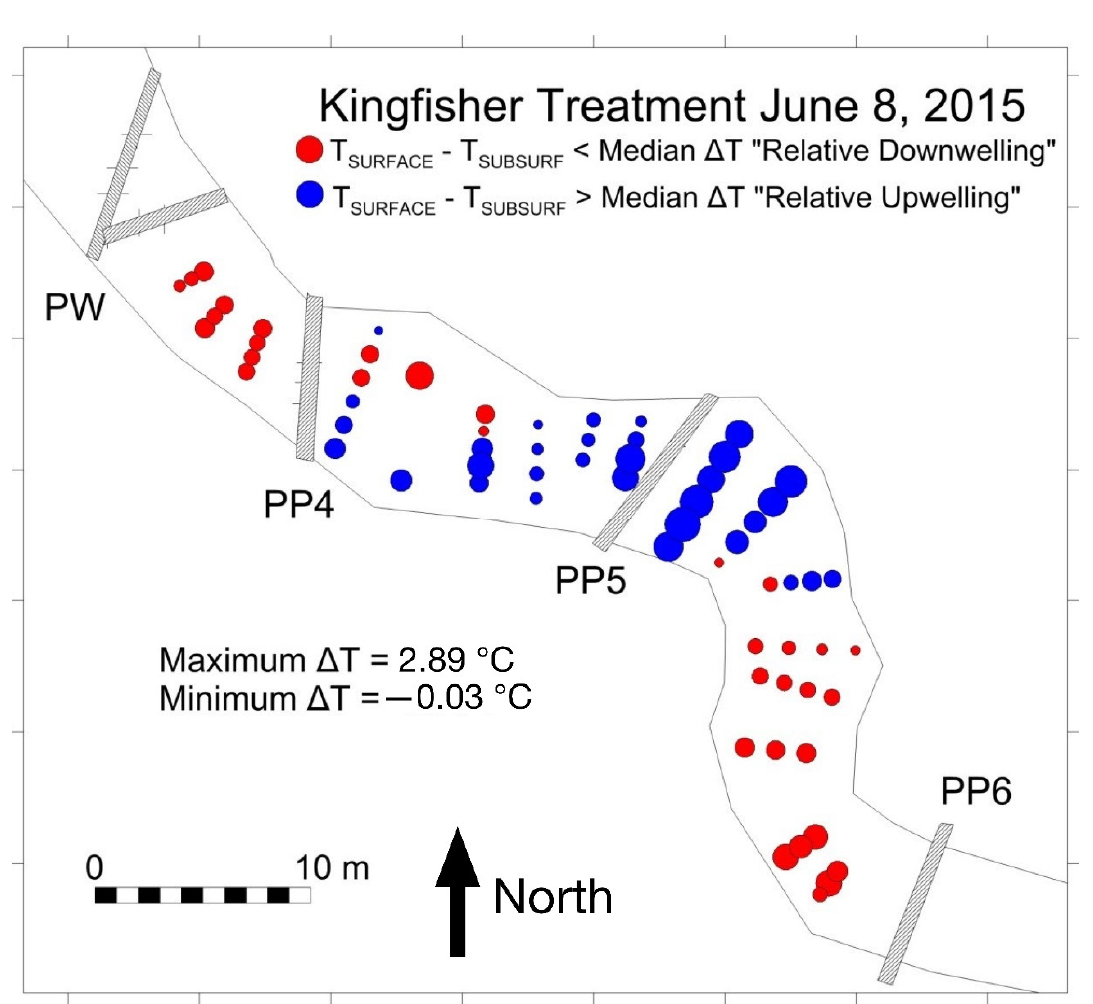
Figure 10. Map showing relative downwelling (red) and upwelling (blue) at the post-project Kingfisher Treatment site. The dots in the legend represent 1.0 ◦ C temperature di ff erence. PP4–6 are sill logs for plunge-pool structures No. 4–6, and PW is a pocket-water log structure.